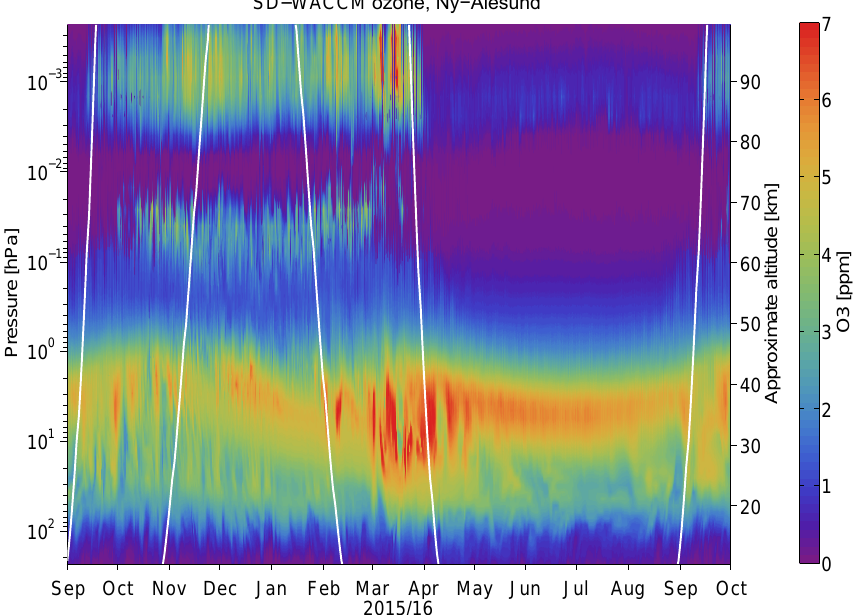
Figure 4. Time series of ozone volume mixing ratio modelled by SD-WACCM above Ny-Ålesund. The white lines indicate the beginning and ending of the polar day and the polar night respectively. The main ozone layer (50–1hPa), the secondary ozone layer (0.005–0.0005hPa) and the tertiary ozone layer (0.1–0.02hPa) are clearly visible. During the sudden stratospheric warming in March 2016, there was strong enhancement of ozone in the secondary ozone layer, which coincides with a decrease in the tertiary ozone